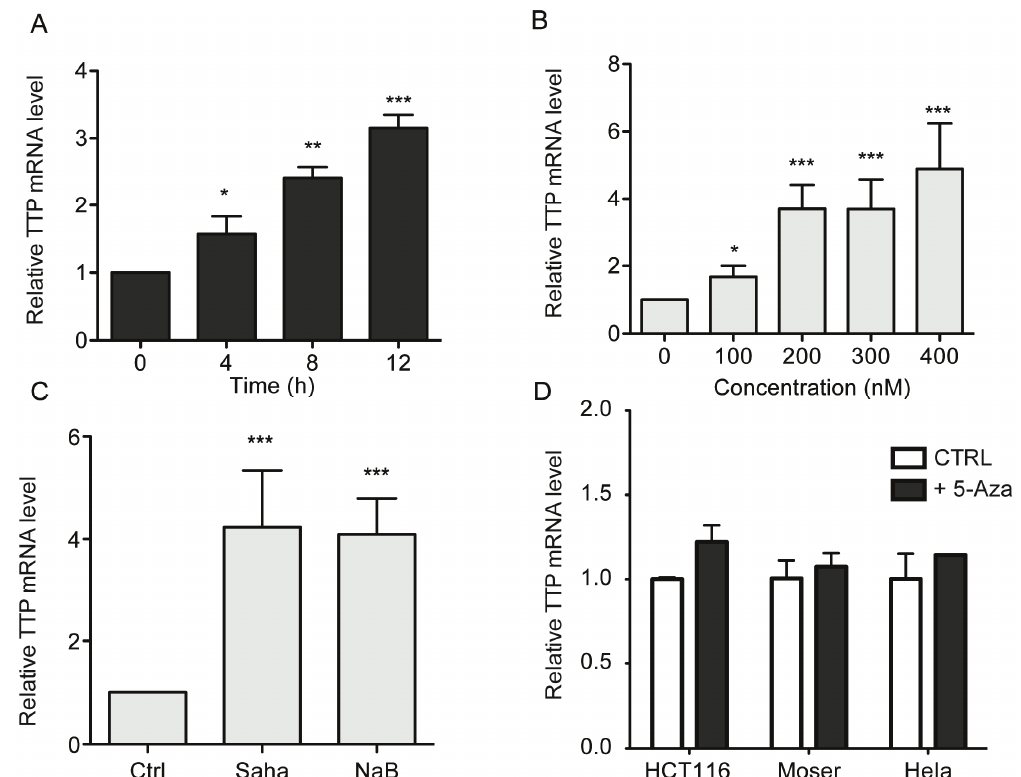
Figure 2. HDAC inhibitors promote TTP expression. ( A ) Time course of TTP mRNA expression in HCT116 cells treated with 0.4 (cid:3)M TSA. ( B ) TTP induction in HCT116 cells treated cells treated with different doses of TSA for 12 h. ( C ) HCT116 cells were treated for 12 h with 5 (cid:3)M SAHA or 5 mM sodium butyrate (NaB) and assayed for TTP mRNA expression by qPCR. ( D ) Cells (HCT116, Moser, and HeLa) untreated or treated with 10 (cid:3)M 5-Aza-dC for 48 h were examined for TTP mRNA levels by quantitative PCR using GAPDH as normalization control. The data represent the mean of three independent experiments (± SD). * p < 0.05, ** p < 0.01, *** p <